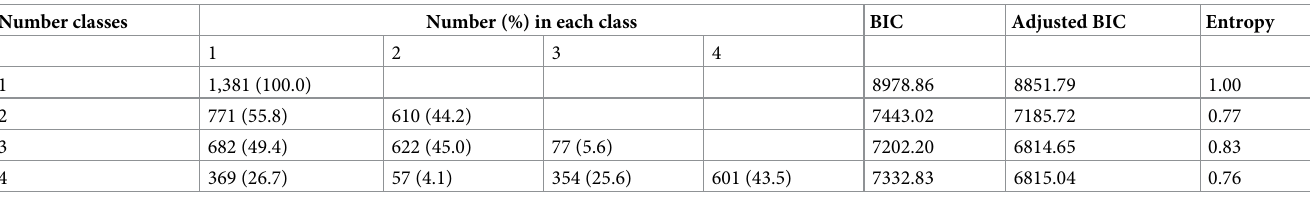
Table 1. Summary of model fit